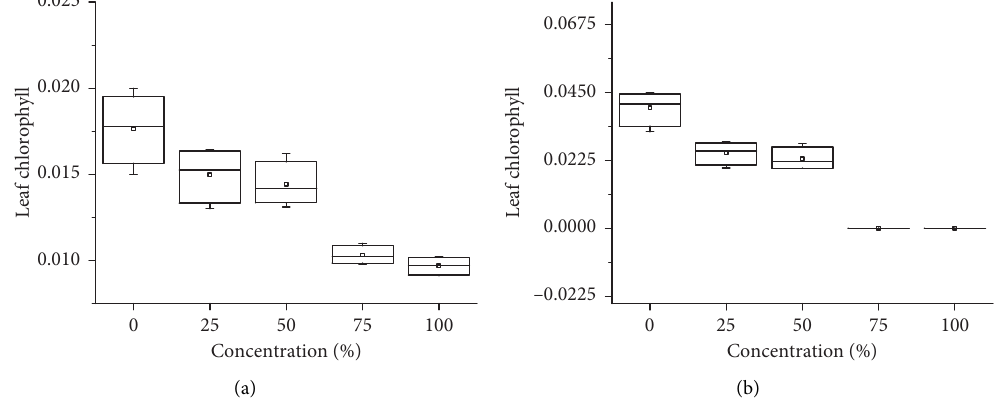
Figure 10: Leaf chlorophyll content of P. vulgaris (a) and O. sativa (b) seedlings in screen house experiment after 7 and 14 days of treatment with S. suaveolens extracts,